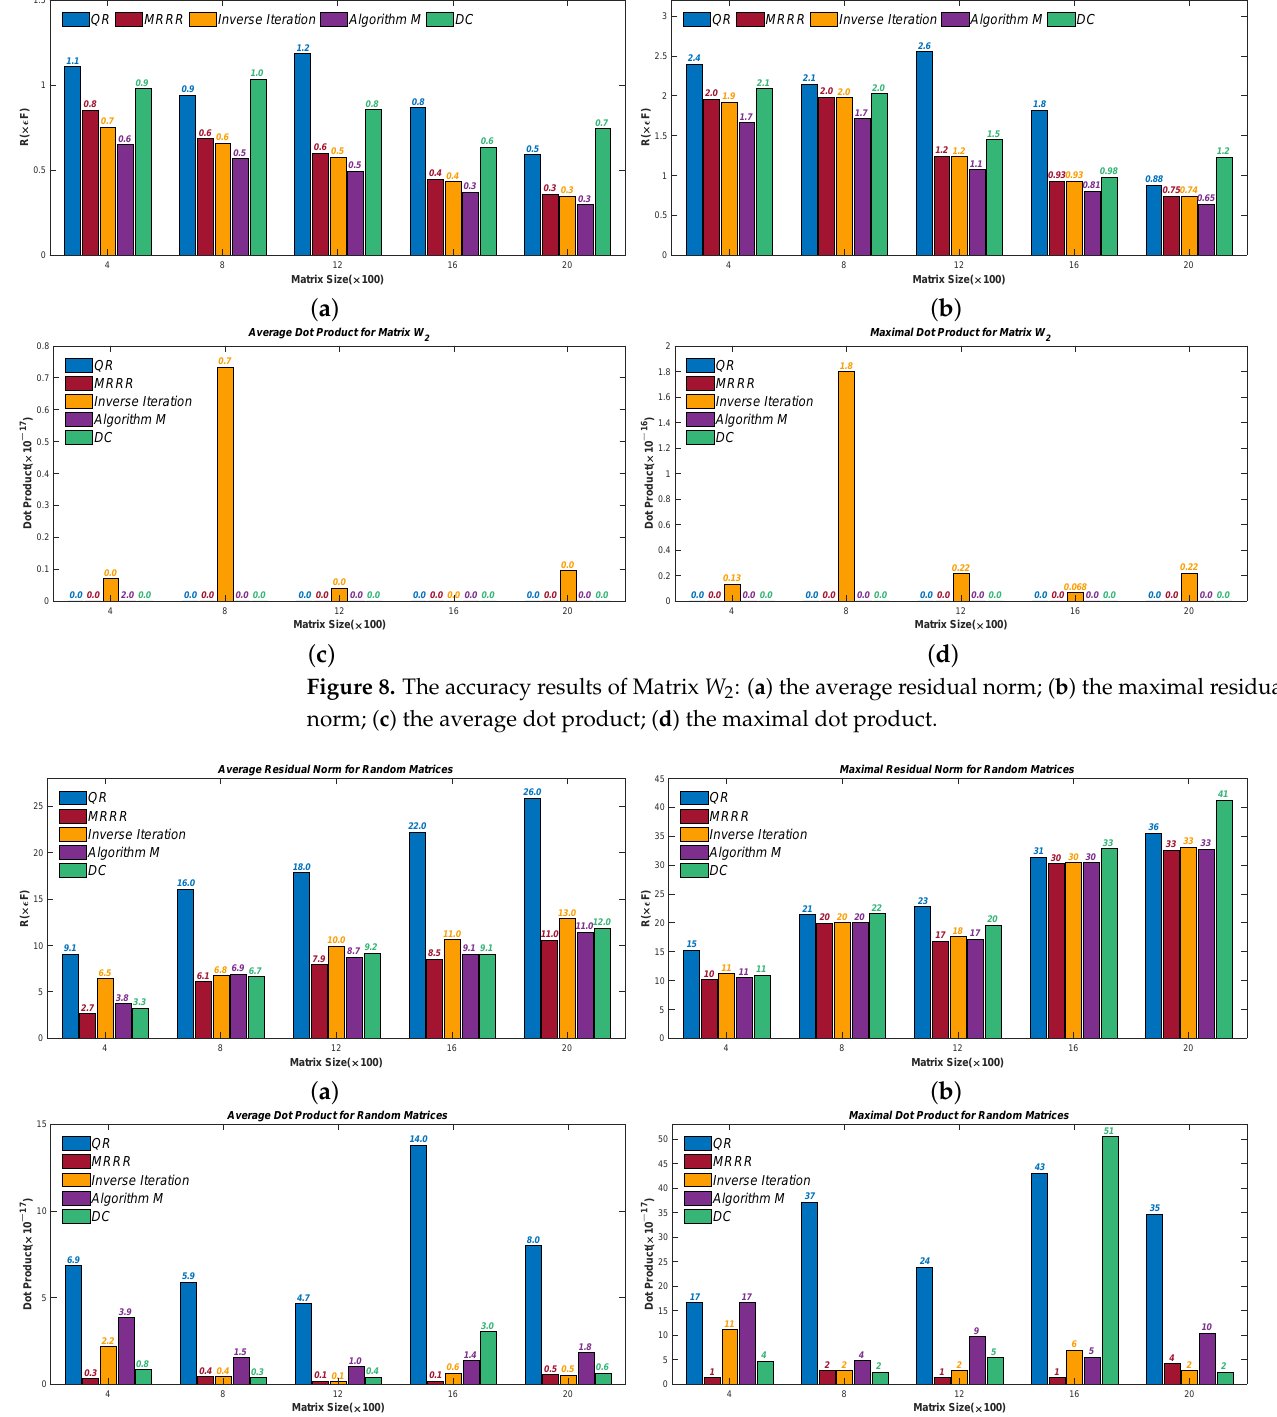
Average Dot Product for Random Matrices